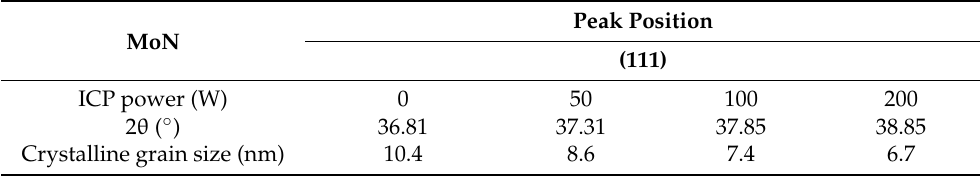
Table 1. XRD data of MoN coatings for ICP assisted